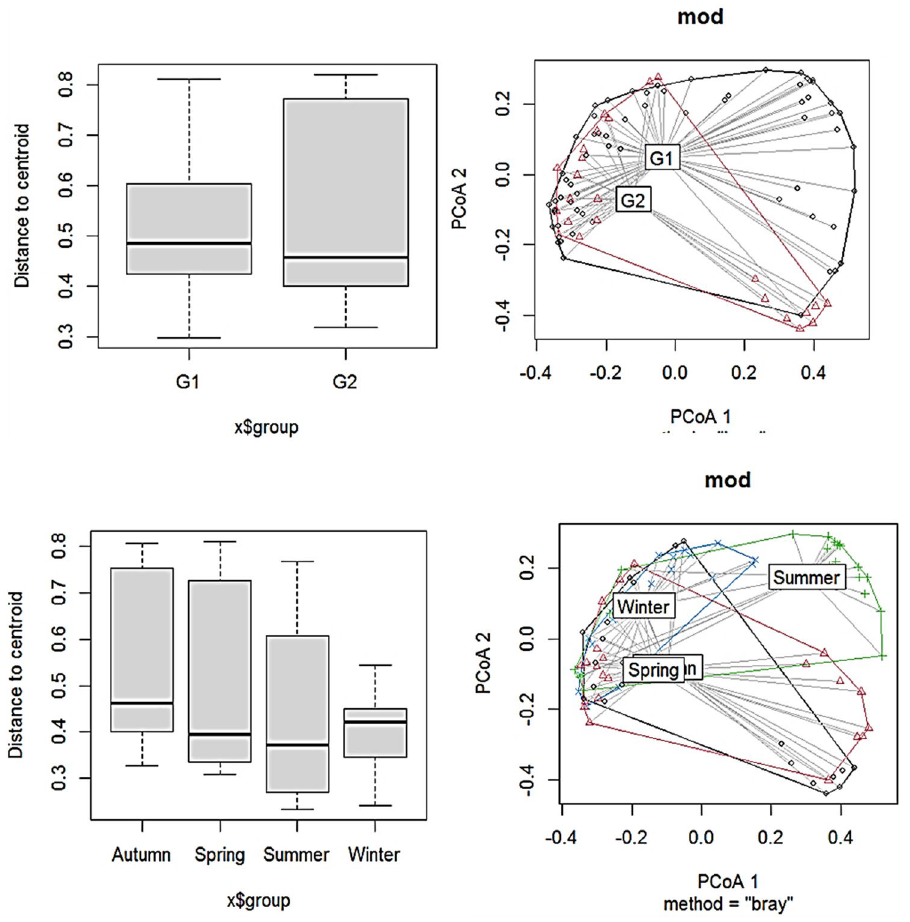
Figure 5. Betadisper plot showing the difference in species compositions across seasons and